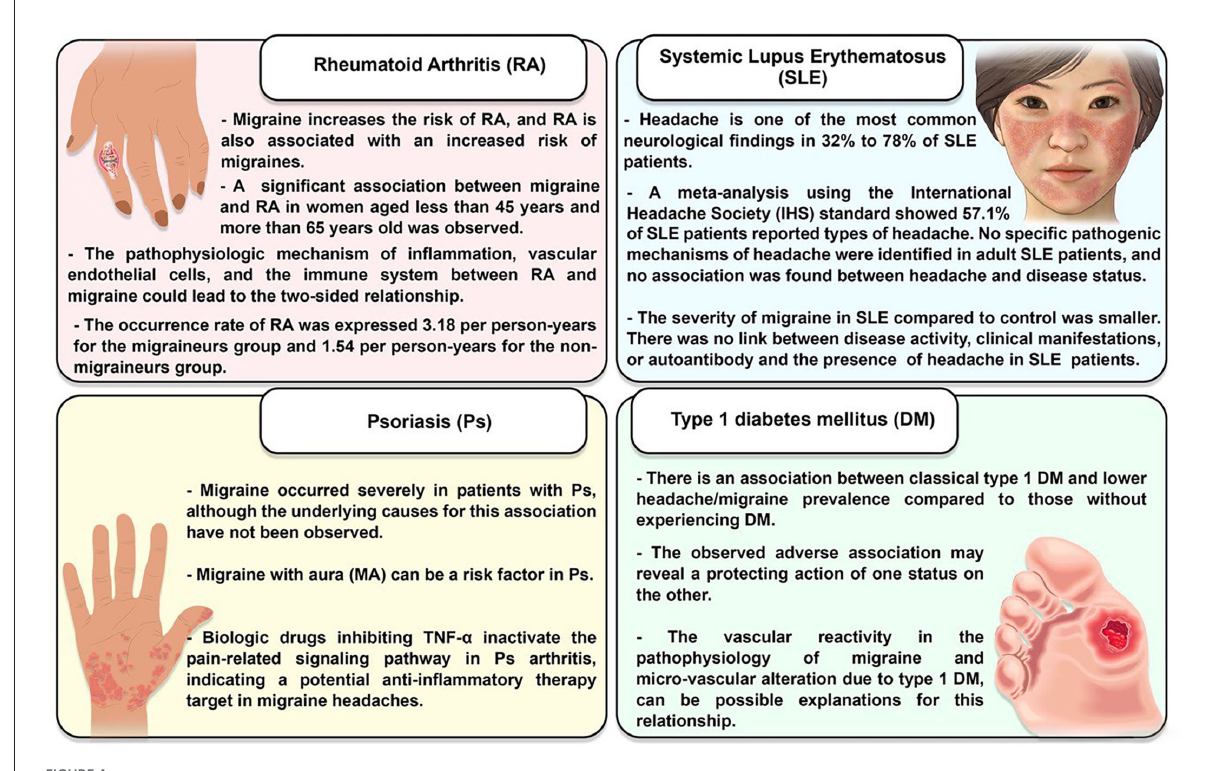
FIGURE4 Migraine is a possible risk factor for RA, SLE, and proteus syndrome (Ps) but not